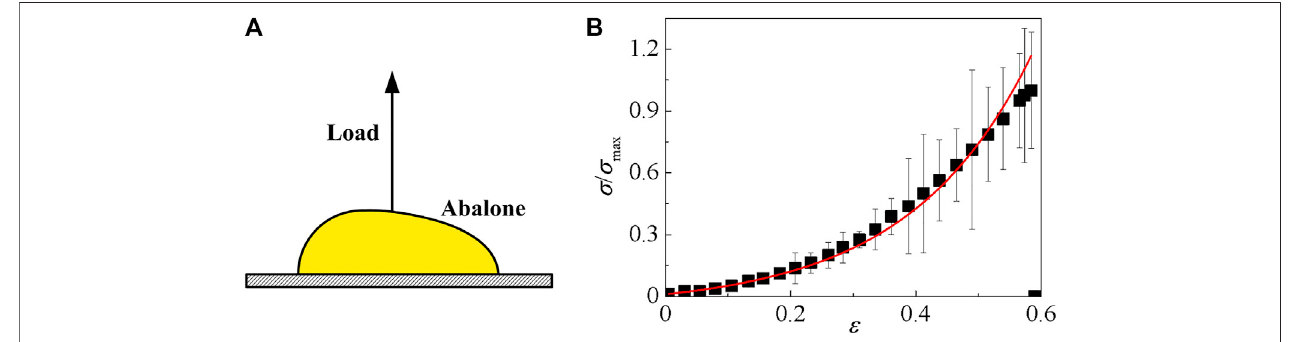
FIGURE7| Strength measurementexperiment on theabalone (A) SchematicoftheExperiment (B) Therelationshipbetweenthedimensionless pulling stressand the strain.